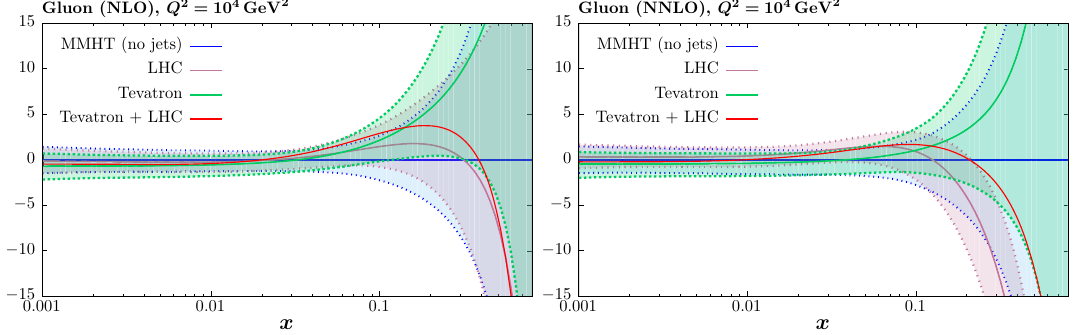
for the default NNLO fit, and to the same fit but using the NLO theory, i.e. with the NNLO K -factors omitted. The left (right) plots correspond to the ‘low’ and ‘high’ jet radii described in the text